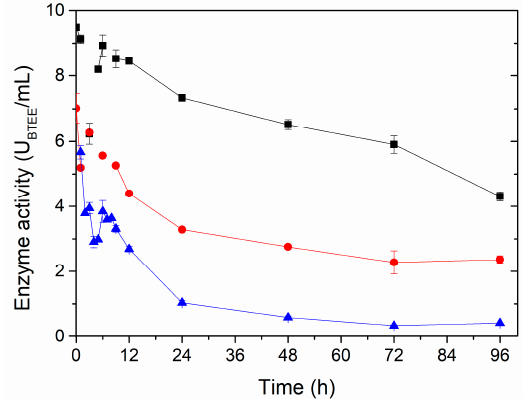
Figure 2. Immobilization profiles of Novo-Pro D (NPD) on agarose-glyoxyl (20 °C, pH 10.0, protein load of 4.6 mg/g support). ( ■ ) Enzyme control—free enzyme solution under the immobilization conditions, ( • ) suspension activity, and ( (cid:78) ) supernatant activity. Activities were measured as described in Section